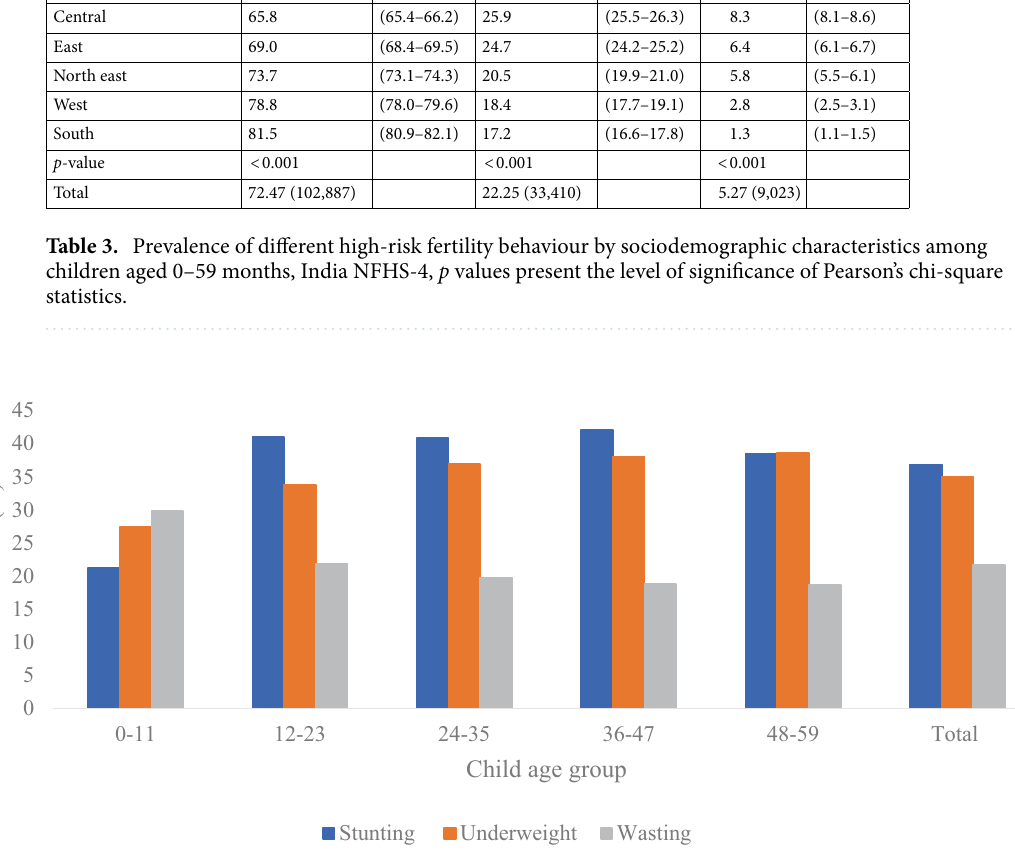
Figure 1. Prevalence of the stunting, wasting, and underweight among child age group 0–59 months, India,